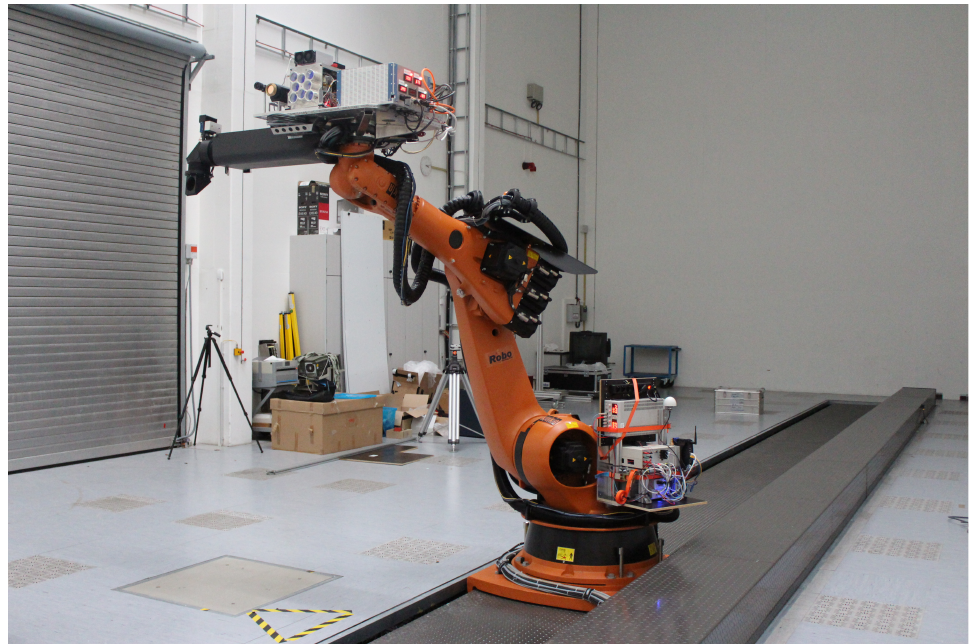
Figure 13. 3D flash LiDAR of project FOSTER 2 NAV mounted on robot 1 with the flange positioned horizontally. Supporting equipment at the robot